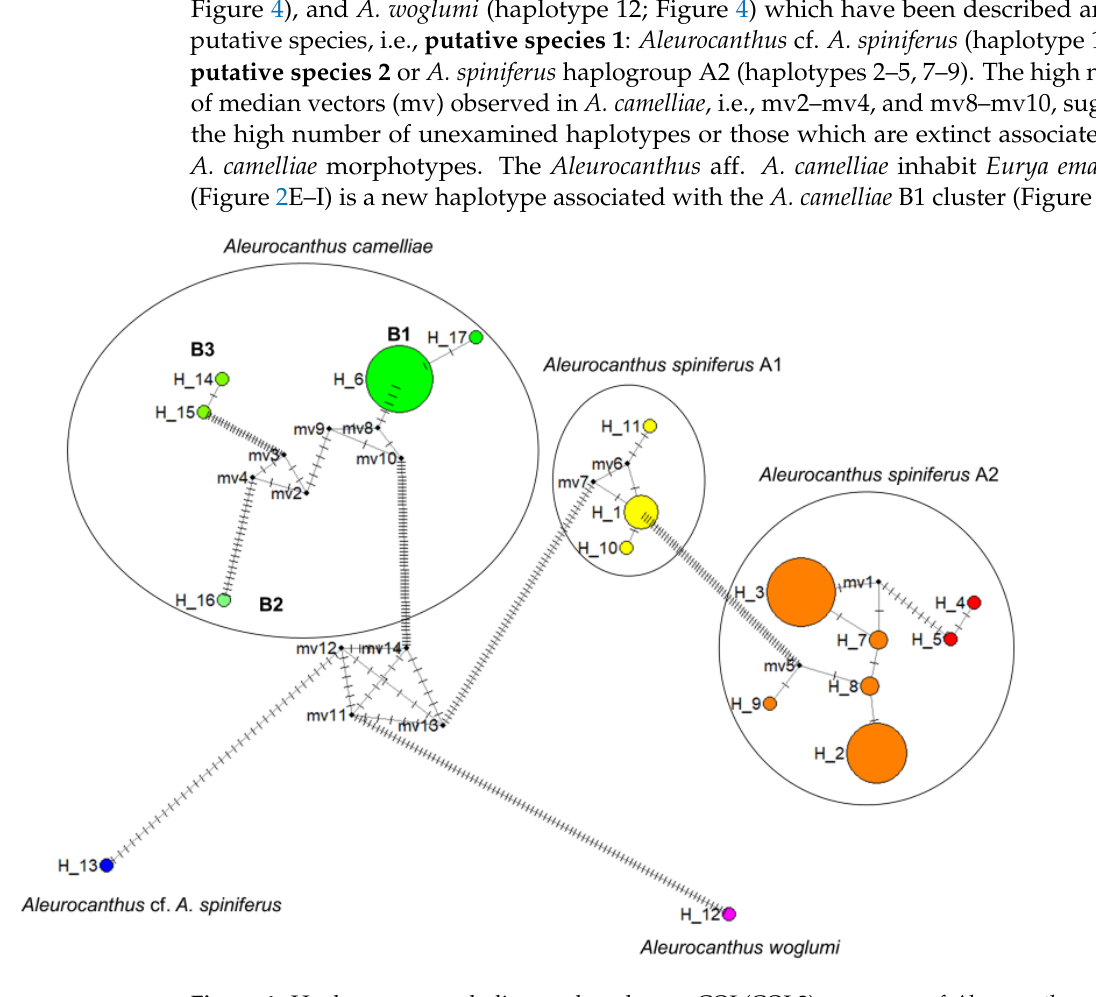
Figure 4. Haplotype network diagram based on mtCOI (COI-2) sequences of Aleurocanthus spiniferus species complex. Green nodes are A. camelliae haplotypes; yellow and orange nodes are A. spiniferus haplogroup A1 and A2, respectively; blue node is Aleurocanthus cf. A. spiniferus ; purple node is A. woglumi ; red nodes are A. spiniferus A2 recombinant haplotypes. Black nodes are median vectors. Striped lines indicate the number of nucleotide mutations. The size of nodes indicates the number of sequences clustered in haplotypes.